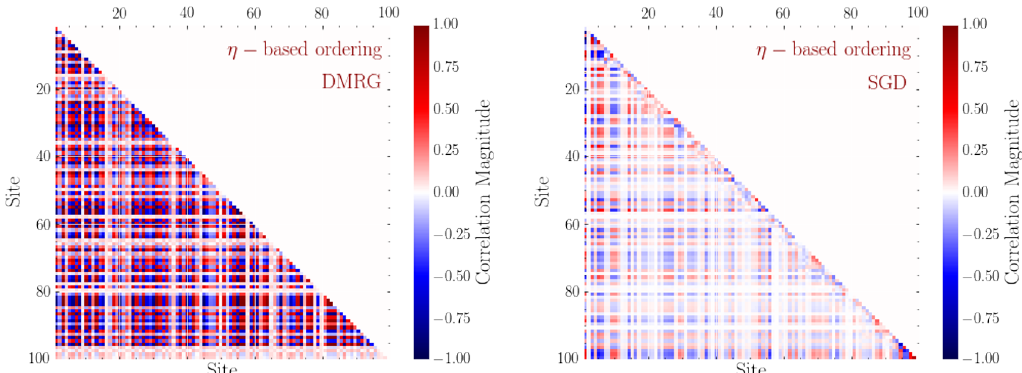
Figure 15 . The left panel shows the correlation matrix, with respect to σ z , of the MPS sites which has trained via the DMRG algorithm, and the right panel shows the same for the MPS trained with